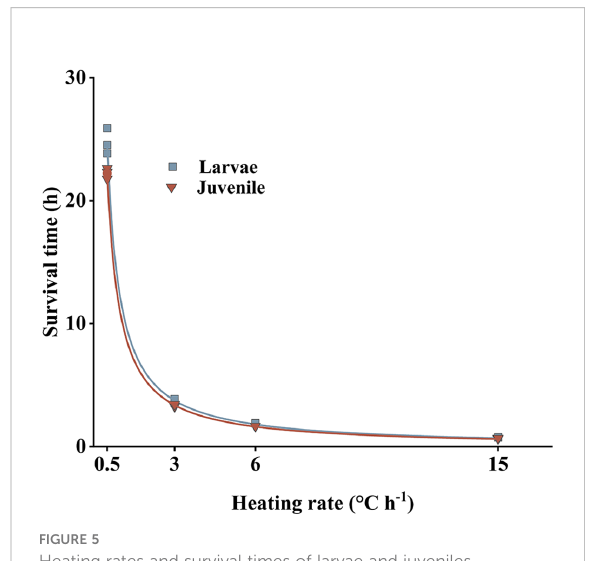
FIGURE 5 Heating rates and survival times of larvae and juveniles Larimichthys crocea .